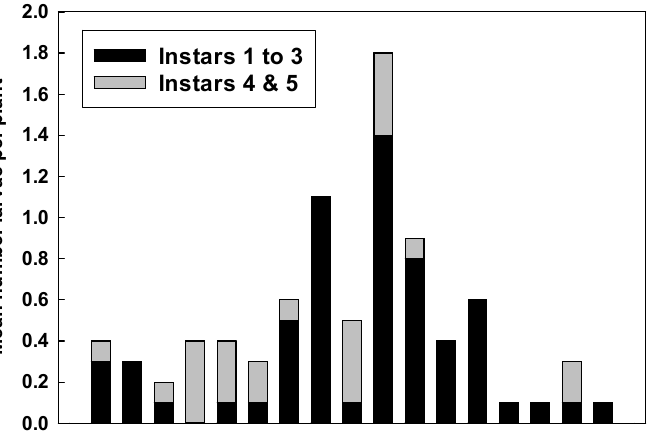
Figure 7. Numbers of young (instars 1–3) and mature (instars 4–5) monarch larvae recorded weekly on tropical milkweed ( A. curassavica ) at Googleplex, Mountain View, CA during 2 February to 31 May 2021. Seven pupae were found on A. curassavica (4), adjacent grasses (2) and L. perezii (1) during 31 December and 2 February. Of these, two produced adults in mid-late February, 25 and 34 days after being found. The remainder disappeared (3) or were non-viable (2). 3.3. Infection of Monarch Adults by the Protozoan Parasite Ophryocystis elektroscirrha (OE) Monarchs ( n = 492) that eclosed between 17 January and 12 June were tested for the presence of OE spores. Of these, 356 (72.4%) had 100 or more spores and 46.3% (228) were heavily infected with >1000 spores. Only 136 (27.6%) had zero or less than 100